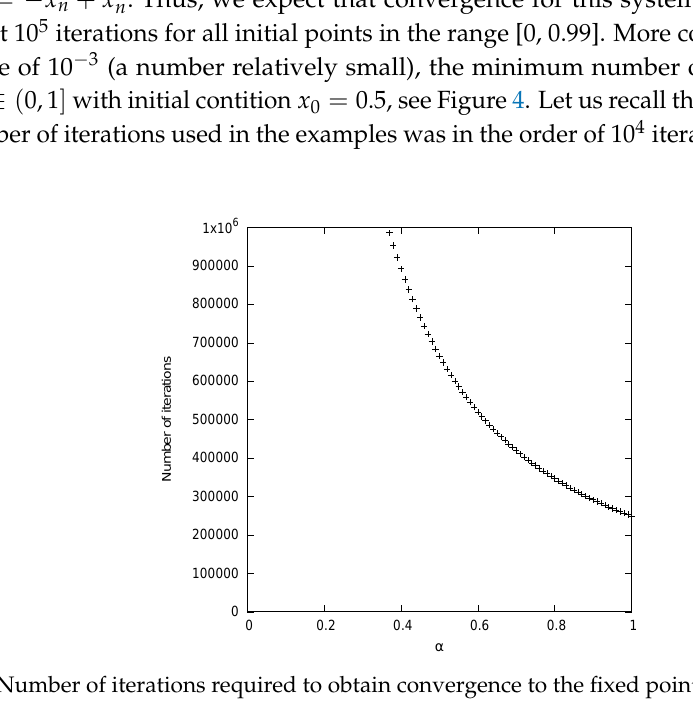
Figure 4. Number of iterations required to obtain convergence to the fixed point given a tolerance of ( 0, 1 ) and initial condition x 0 = 0.5. 10 − 3 for α ∈ 10 − 3 for α ∈ ( 0,1 ) and initial condition x 0 =